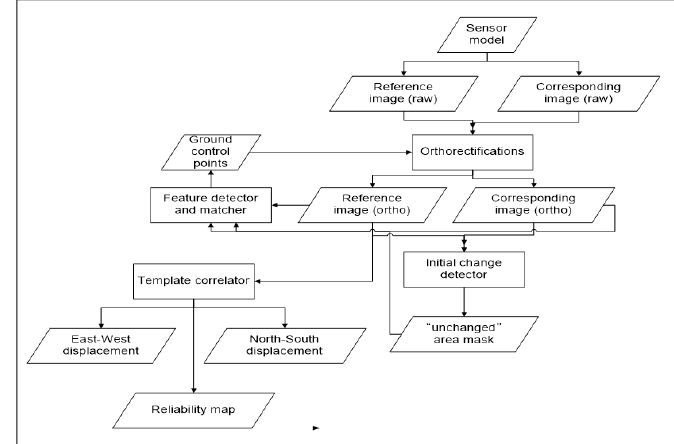
Figure 2. Validation of geodetic control using the strategy in